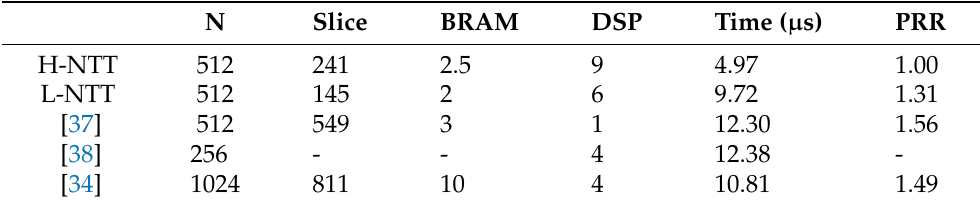
Table 3. PRR comparison of NTT’s FPGA